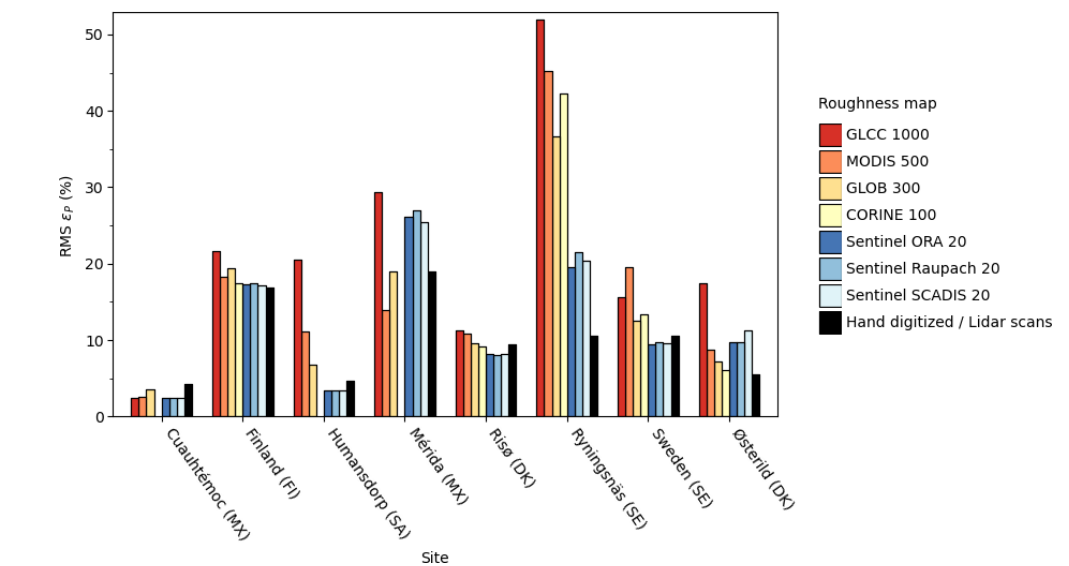
Figure 8. RMSE in power density ( ε P , %) estimated with different input maps for all eight sites combined.